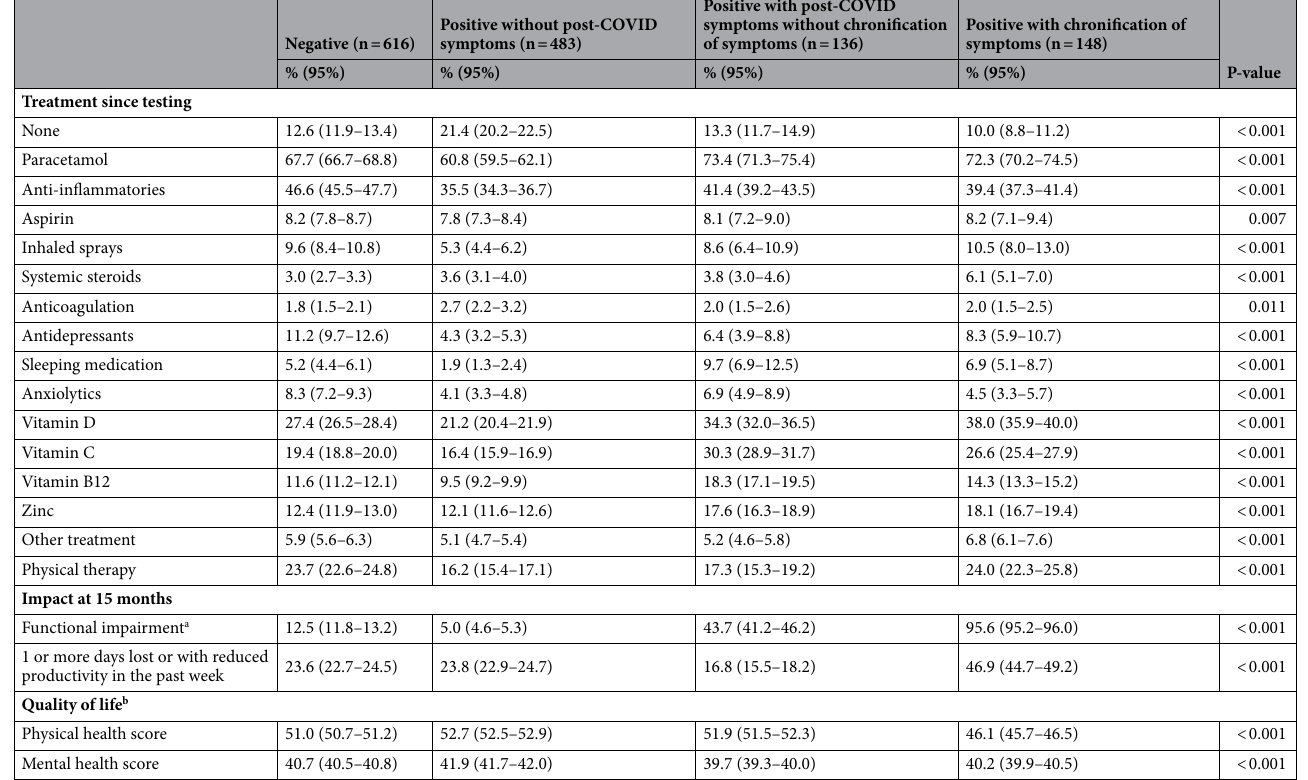
Table 2. Adjusted frequency estimates of treatment, functional impairment and quality of life in SARS-CoV-2 positive individuals with and without chronification of symptoms, and SARS-CoV-2 negative individuals (n = 1383). Estimates were adjusted for age, sex, physical activity, smoking status, vaccination status, hospitalization, self-rated health prior to testing, symptoms at time of testing and the following